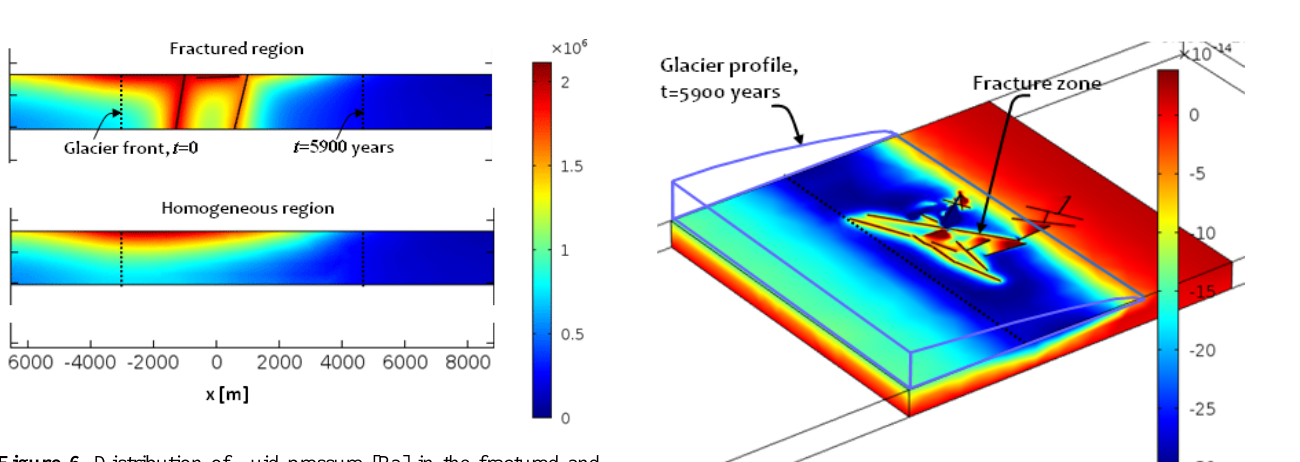
Figure 6. Distribution of fluid pressure [Pa] in the fractured and homogeneous regions of the rock in cross sections y = const at time 5900 years. For the fractured region y = 6200m. The rock is subjected to spatially non-uniform fluid pressure and compressive stress.